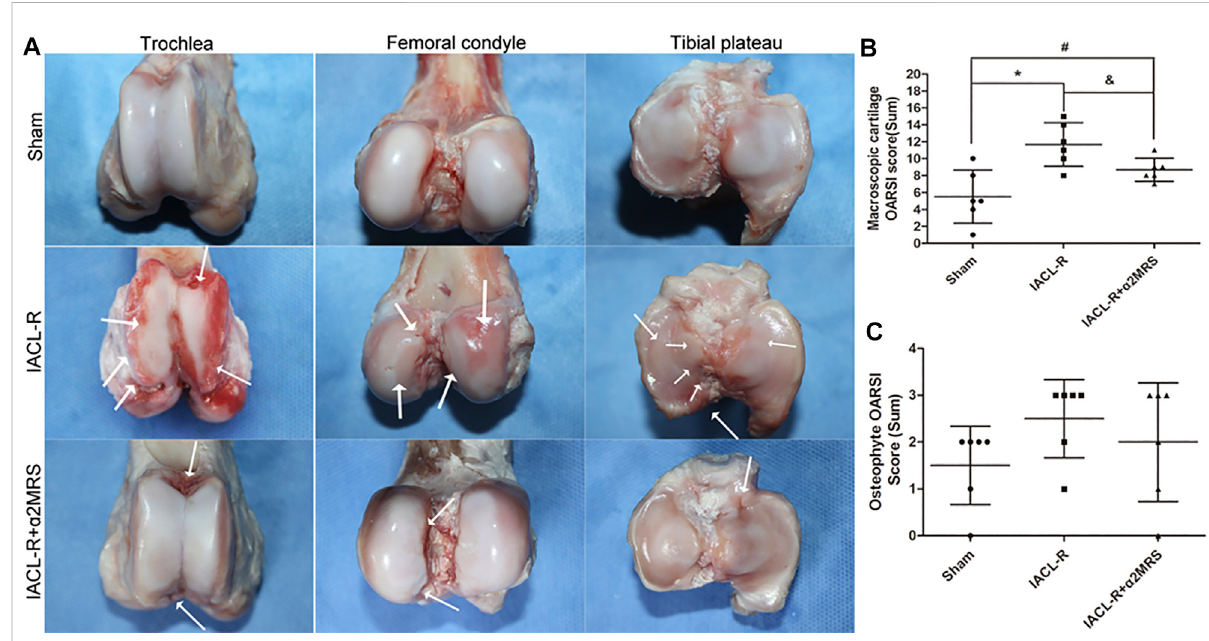
FIGURE 7 (A) : Images of the trochlea, femoral condyle, and tibial plateau for the macroscopic cartilage and osteophyte assessment according to OARSI guidelines. The white arrows indicate cartilage damage, irregularities, and osteophytes. (B) : Macroscopic cartilage score were lower in the IACL- R+ α 2MRS group than in the IACL-R group ( p = 0.031). (C) : Macroscopic osteophyte scores did not differ among the different groups ( p = 0.438). * = p < 0.05, sham group versusIACL-R group; # = p < 0.05, sham group versusIACL-R+ α 2MRS group; and = p < 0.05, IACL-R group versusIACL- R+ α 2MRS group. The bars show the mean ± SD ( n =